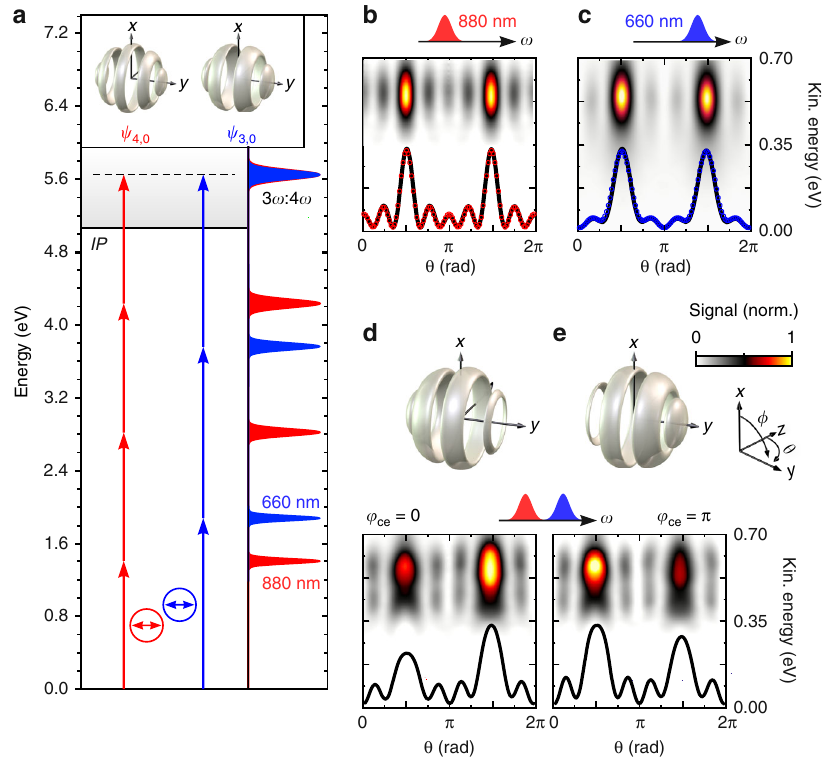
Fig. 2 Coherence properties of FEWPs from 3- vs. 4-photon ionization using PLP pulses. a Ionization scheme of Na atoms interacting with a (3 ω :4 ω ) PLP fi eld. Single color ionization by the red and blue pulse gives rise to g - and f -type FEWPs, respectively, illustrated on top. b and c display energy-calibrated sections in the x - y -plane through the FEWPs in polar representation, along with fi ts of the angular distribution (dots), taking into account additional contributions of s -, p - and d -type continua. Superposition of both colors creates an asymmetric state along the laser polarization direction ( y ), with an asymmetry determined by the CEP (see 3D sketches in the insets). d For φ ce = 0, the photoemission is localized in negative y -direction. e By varying the CEP to φ ce = π , the photoemission is switched to the positive y